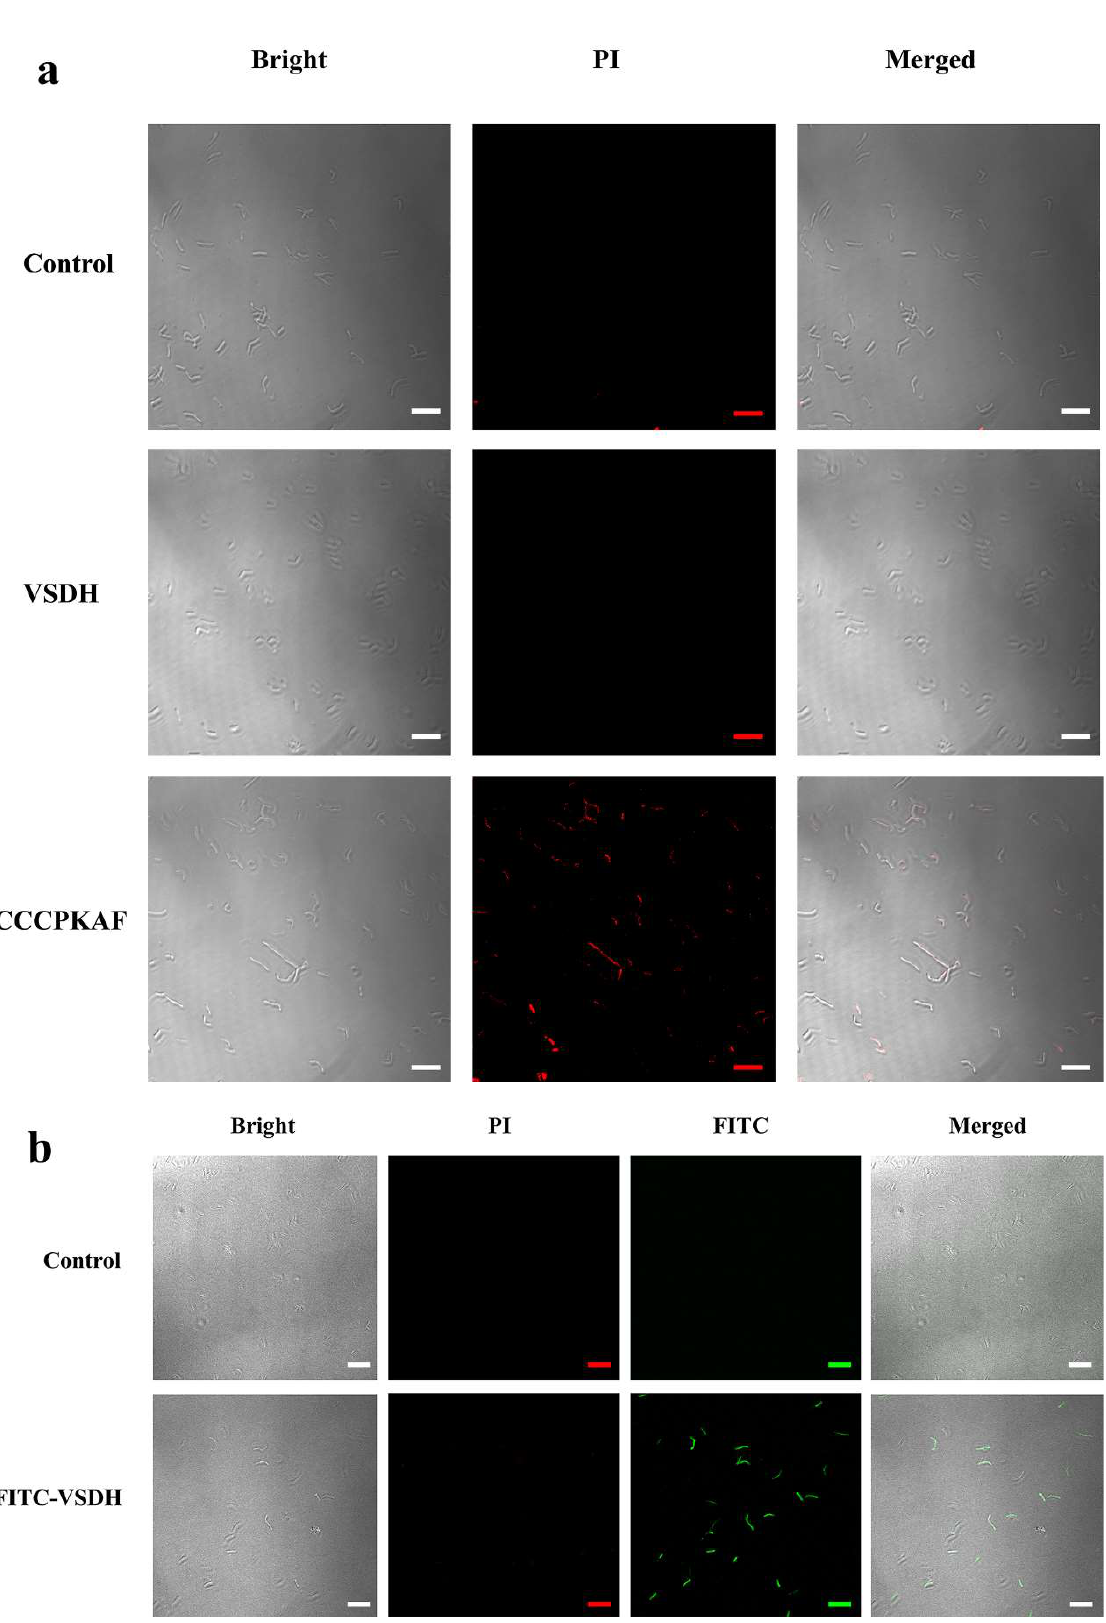
Figure 3 . CLSM images of B . cereus treated with chicken blood plasma peptides: ( a ) B . cereus treated with VSDH and CCCPKAF and PI, the red signal from PI. ( b ) B . cereus treated with FITC-labeled VSDH and PI, green signal from FITC peptides.